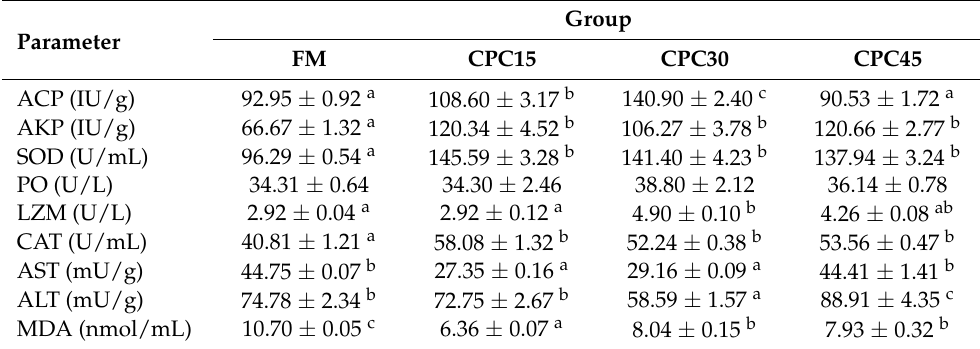
Table 4. Non-specific immune indices in the serum of L. vannamei fed with increasing levels of CPC. Group Parameter FM CPC15 CPC30 CPC45 ACP (IU/g) 92.95 ± 0.92 a SOD (U/mL) 96.29 ± 0.54 a